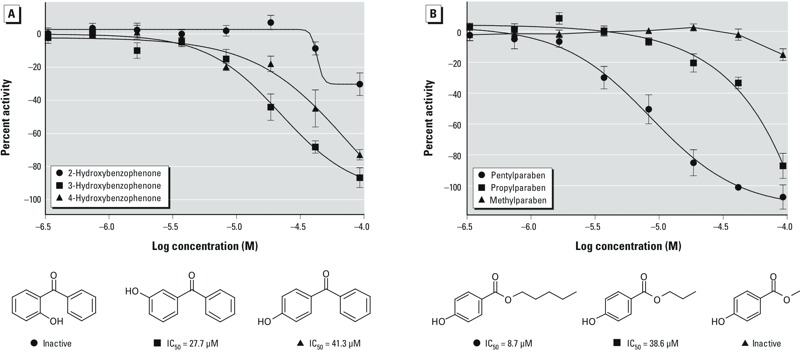
Activity of three hydroxybenzophenone isomers (A) and three parabens (B). (A) Changes in the ability of hydroxybenzophenone isomers to decrease MMP; 3-hydroxybenzophenone was the more potent isomer, and 2-hydroxybenzophenone was inactive in this assay. (B) Decreases in MMP for different paraben molecules; activity increased with increasing length of the side chain (and subsequent increase in hydrophobicity).